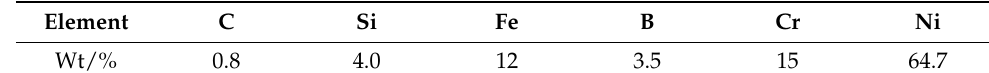
Table 7. Chemical composition of Ni60 alloy powder.